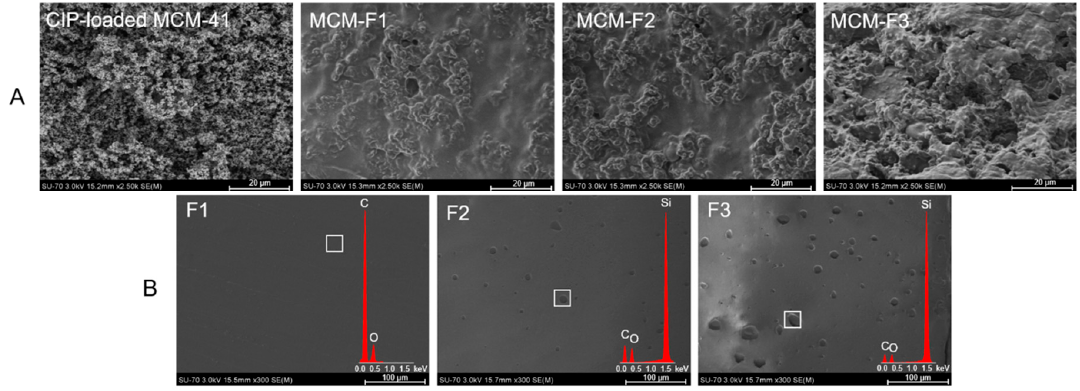
Figure 2. SEM images of CIP-loaded MCM-41, and solid films of: MCM-F1, MCM-F2, MCM-F3 ( A ); F1, F2, F3 ( B ).